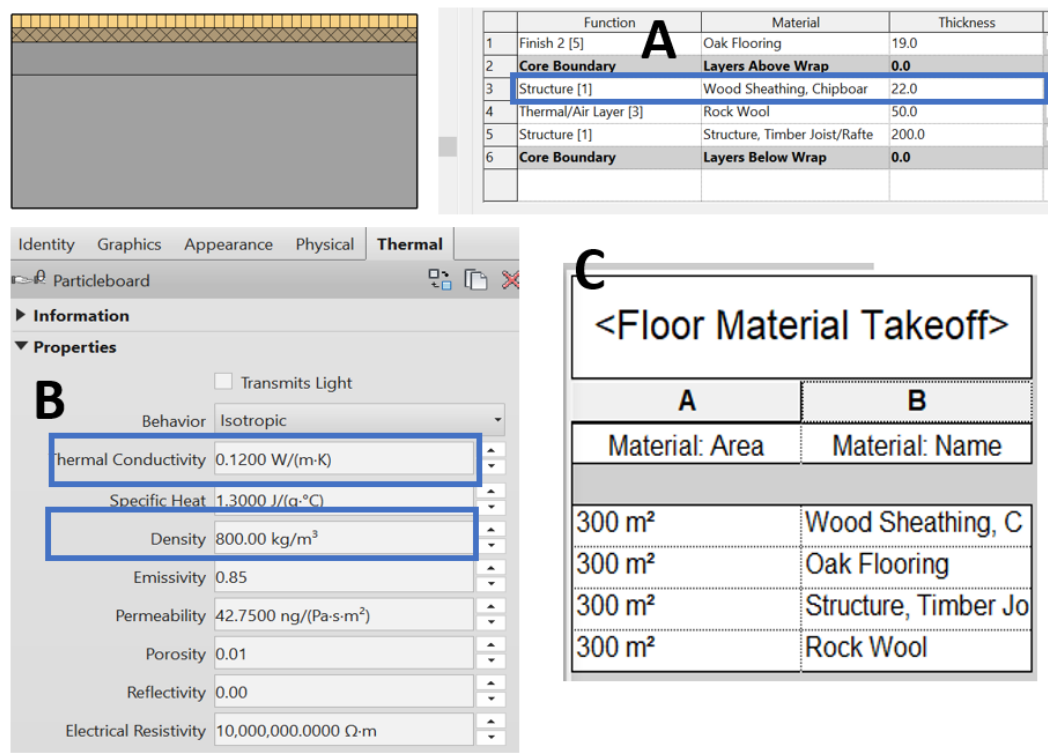
Figure 3. Illustrative Example for a Wood Finish Timber Floor. ( A ) layers of the floor; ( B ) properties of materials used; ( C ) quantity take-off.